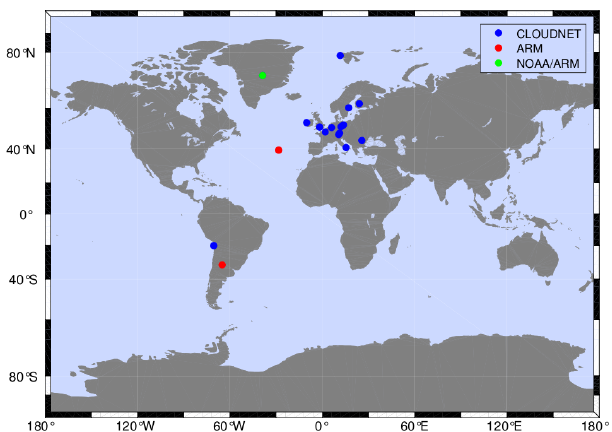
Figure 2. Selection of Cloudnet and ARM sites considered in this